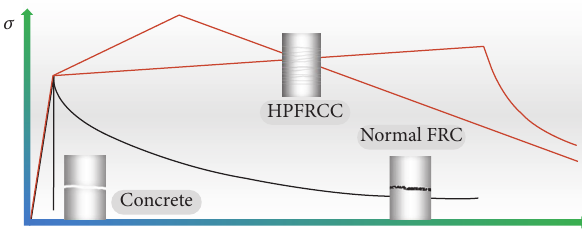
Figure 1: Pseudo-strain hardening behavior of HPFRCC.